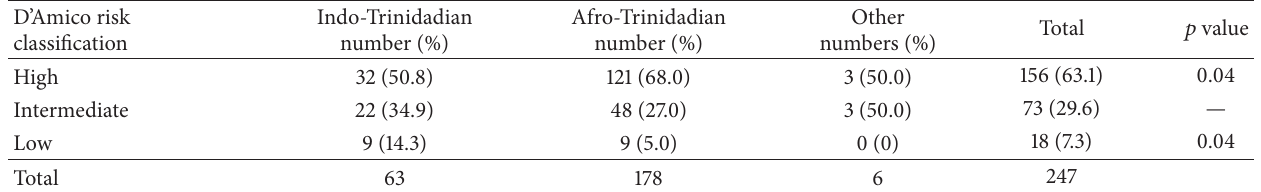
Table 2: Distribution of prostate cancer patients by D’Amico risk group, 𝑛 = 247 .